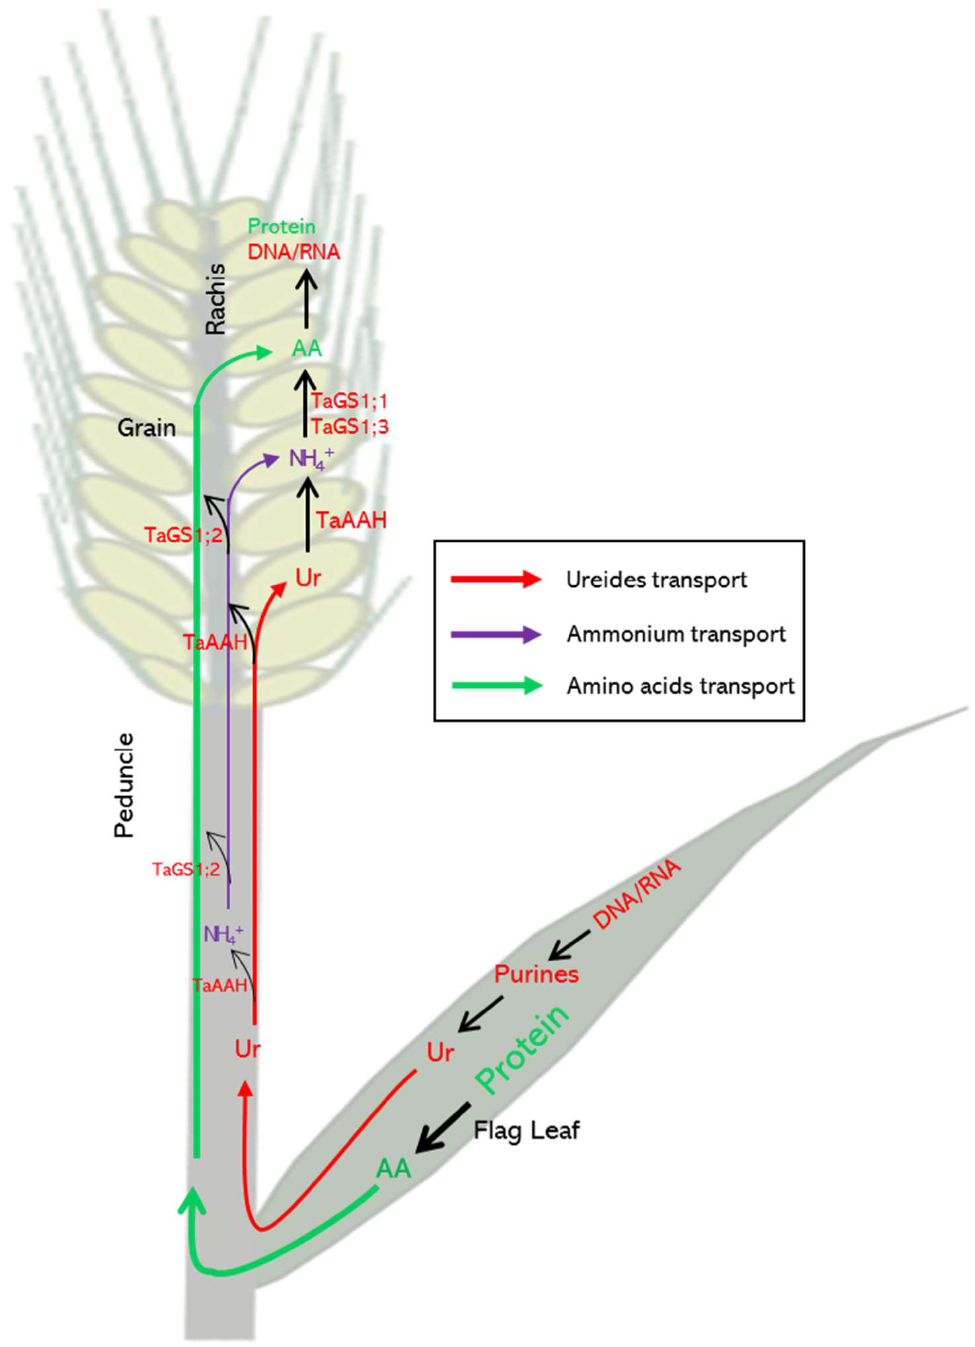
Figure 5. A schematic model of TaGS1;2 involved in the nitrogen remobilization pathway. The transport of ureides (Ur), NH 4+ , and amino acids (AA) is indicated by yellow, purple, and green arrows, respectively. Most of the ureides synthesized in flag leaves is transported to the grain via the phloem. During the transport, part of the ureides is degraded, and the released ammonium is assimilated into Gln by TaGS1;2, which is located in the phloem of the peduncle and rachis.